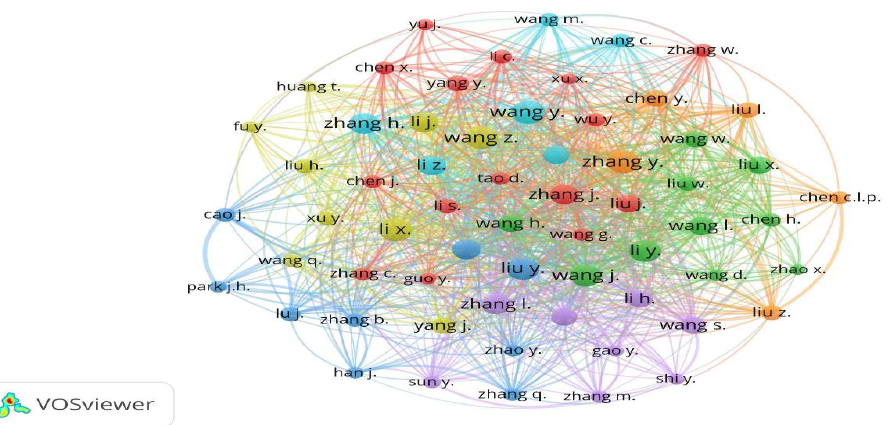
Figure 2. Co-authorship of authors in the leading AI journals during 2020 and 2021.